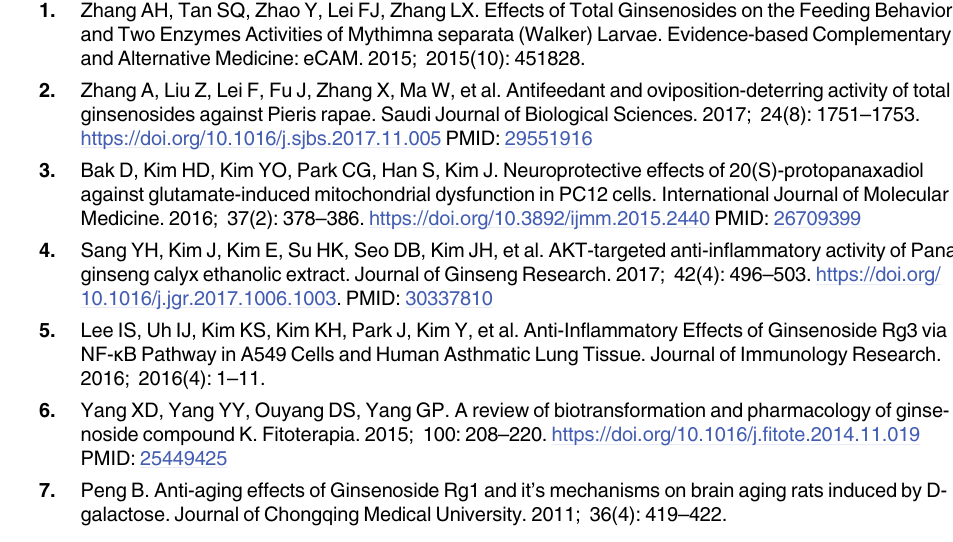
S4 Table. No-choice antifeedant activity of different ginsenoside monomers against the 3 rd -instar larvae of O . furnacalis